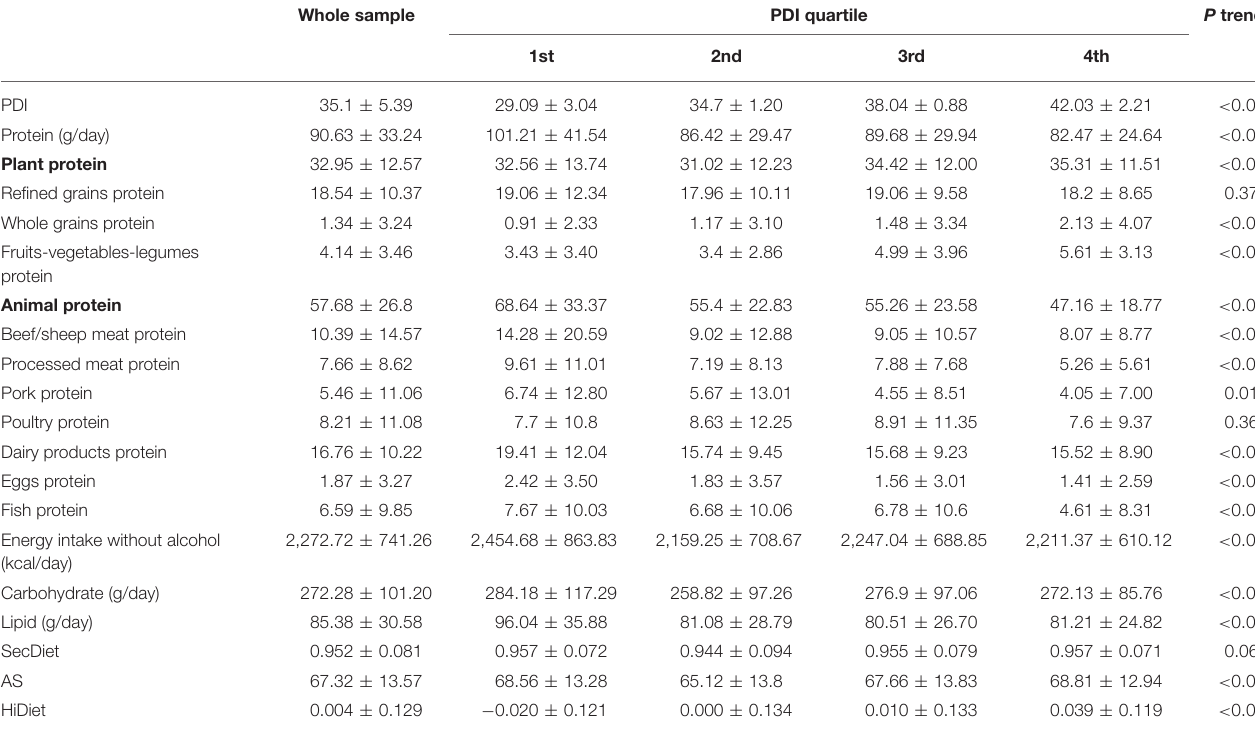
TABLE 1 | Description (mean ± standard deviation) by quartiles of plant-based diet index of the protein, protein categories, carbohydrates, lipid, and energy without alcohol intake and SecDiet, AS, and HiDiet. Whole sample PDI quartile P